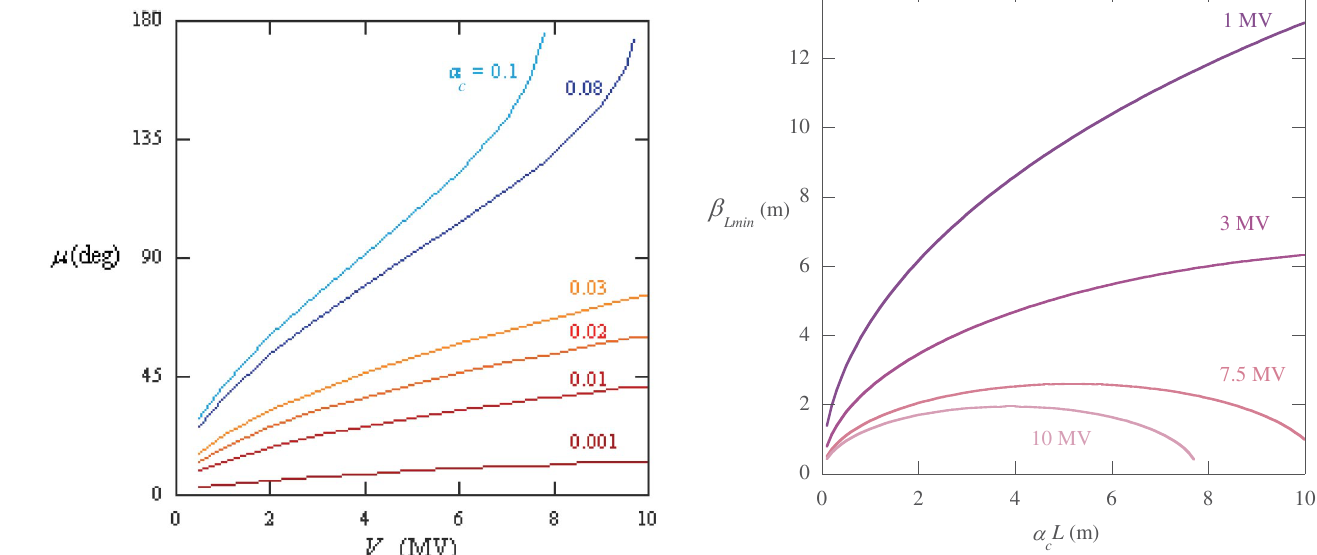
FIG. 3. (Color) Minimum longitudinal betatron function for different values of the rf voltage as a function of the momentum . c